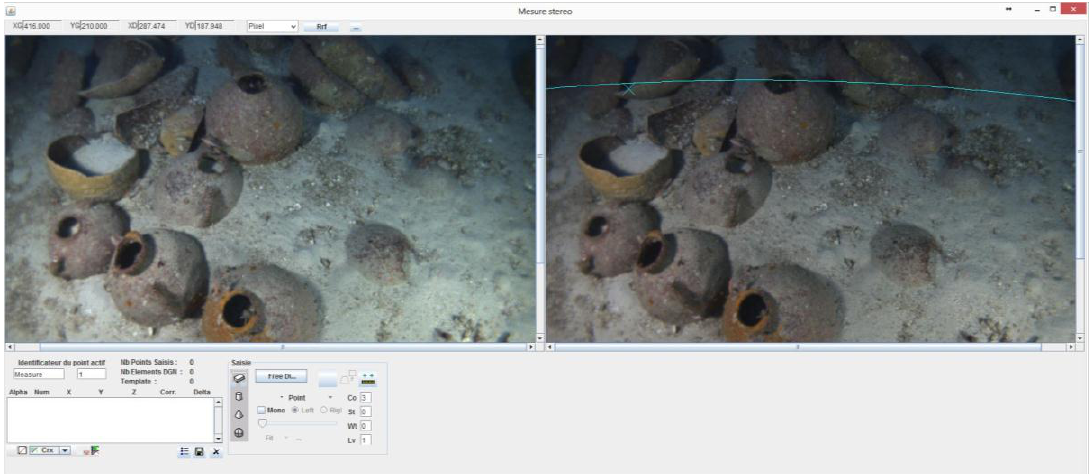
Figure 10. Photogrammetric stereo images taken during odometric navigation while surveying the Xlendi wreck. In the image on the right, one may observe a representation of the epipolar curve clearly showing the strong distortion present in images taken using underwater cameras. Modelling the epipolar line as an arc of circle is essential in calculating the visual odometry in real time as well as in the point cloud densification step (Photograph: GROPLAN consortium, LSIS, COMEX).